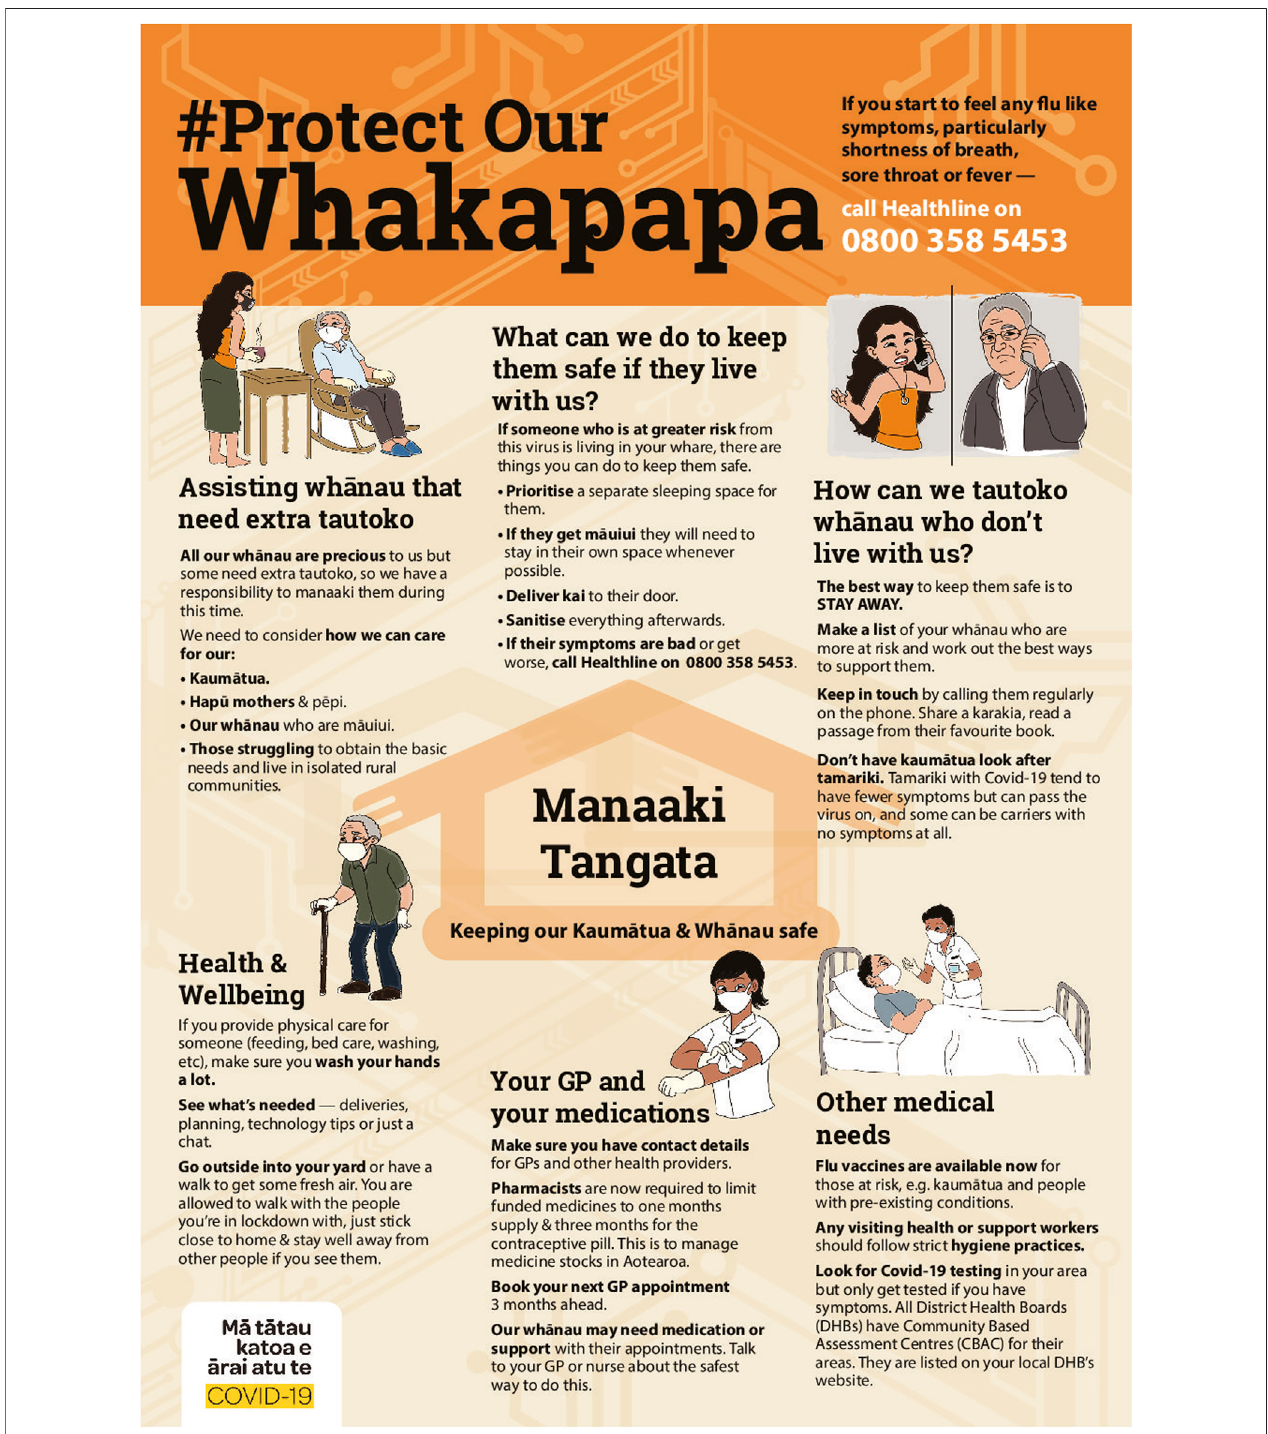
FIGURE 2 | #Protectourwhakapapa Communication Strategy. Source. #ProtectOurWhakapapa (2020).